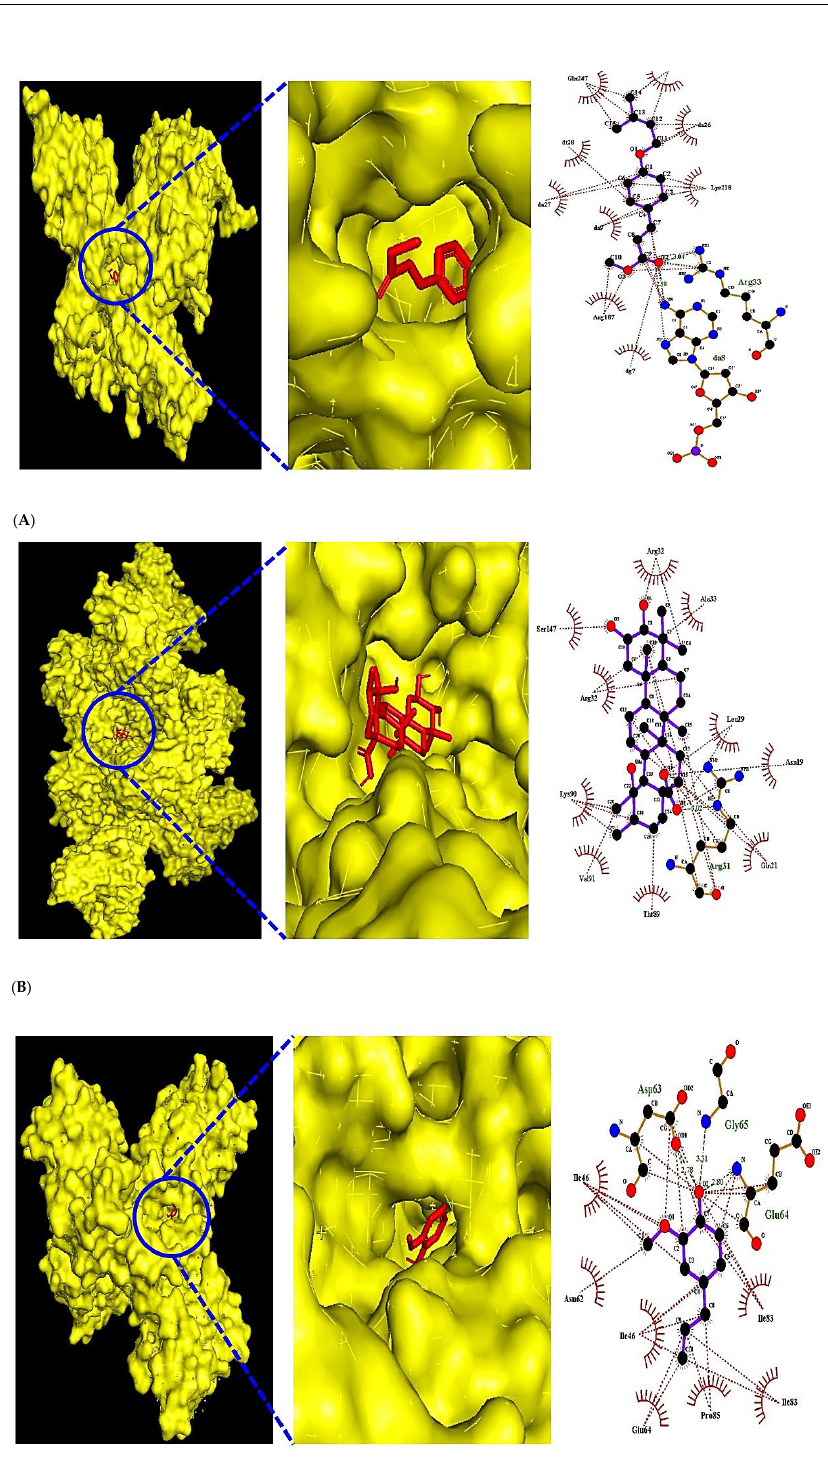
Figure 7. ( A ) The MDT of Methyl 4-prenyloxycinnmate (PubChem ID: 14414116) on RELA (PDB ID: 2O61). ( B ) The MDT of Tormentic acid (PubChem ID: 73193) on TNF (PDB ID: 5YOY). ( C ) The MDT of Eugenol (PubChem ID: 3314) on VEGFA (PDB ID: 3P9W).